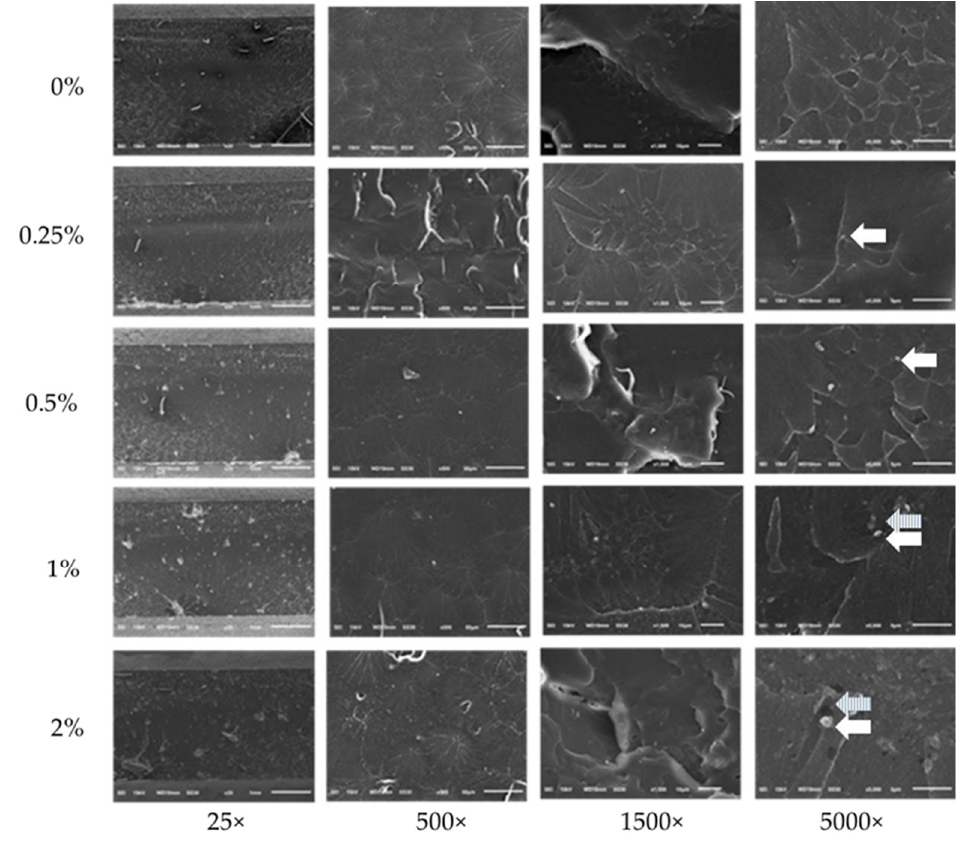
Figure 6. Fractured workpieces under SEM (white arrow: NCC, stripe arrow: the space between the fiber and the matrix) .